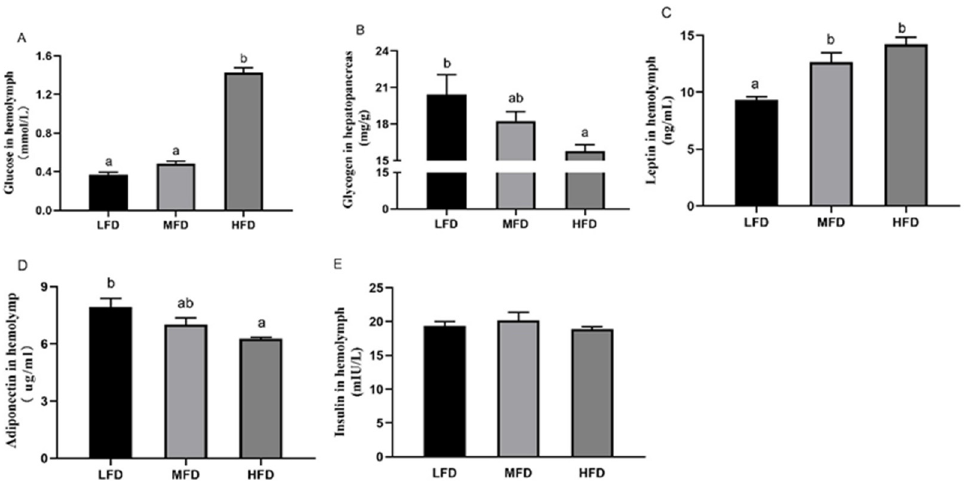
Figure 5. Hemolymph and hepatopancreas parameters after feeding trial. The contents of glucose in hemolymph ( A ), glycogen in hepatopancreas ( B ) and leptin ( C ), adiponectin ( D ) and insulin ( E ) in hemolymph were measured. LFD, low-fat diet; MFD, middle-fat diet; HFD, high-fat diet. Data are presented as mean ± S.E., n = 3. Values with different letters are significantly different ( p <